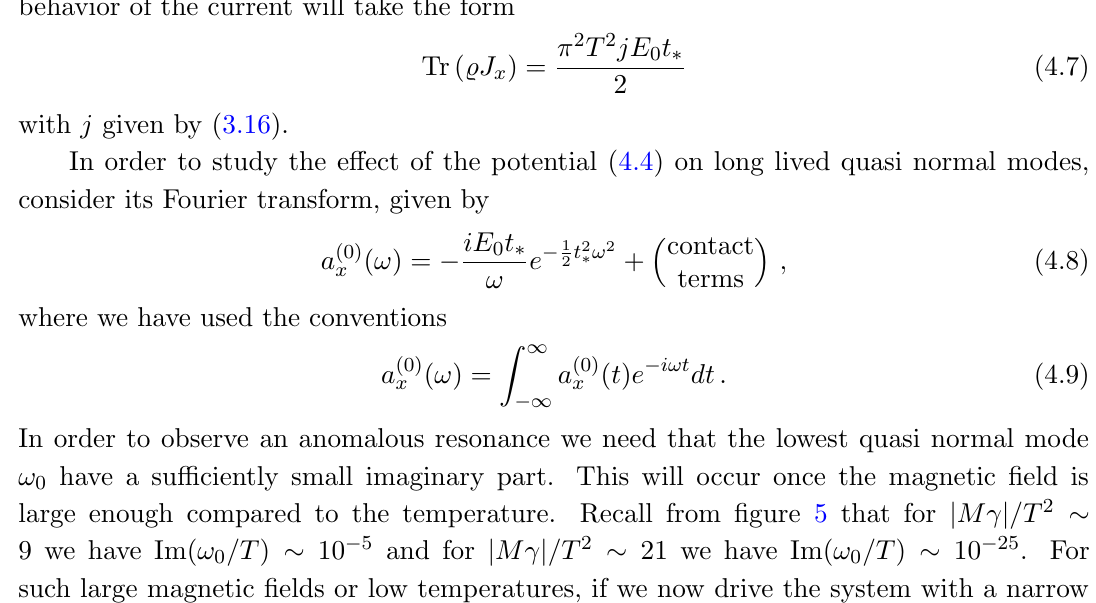
obtained by discretizing the radial coordinate on a Chebyshev grid with 51 collocation points, and 4th order Runge-Kutta for time evolution. See [43] for